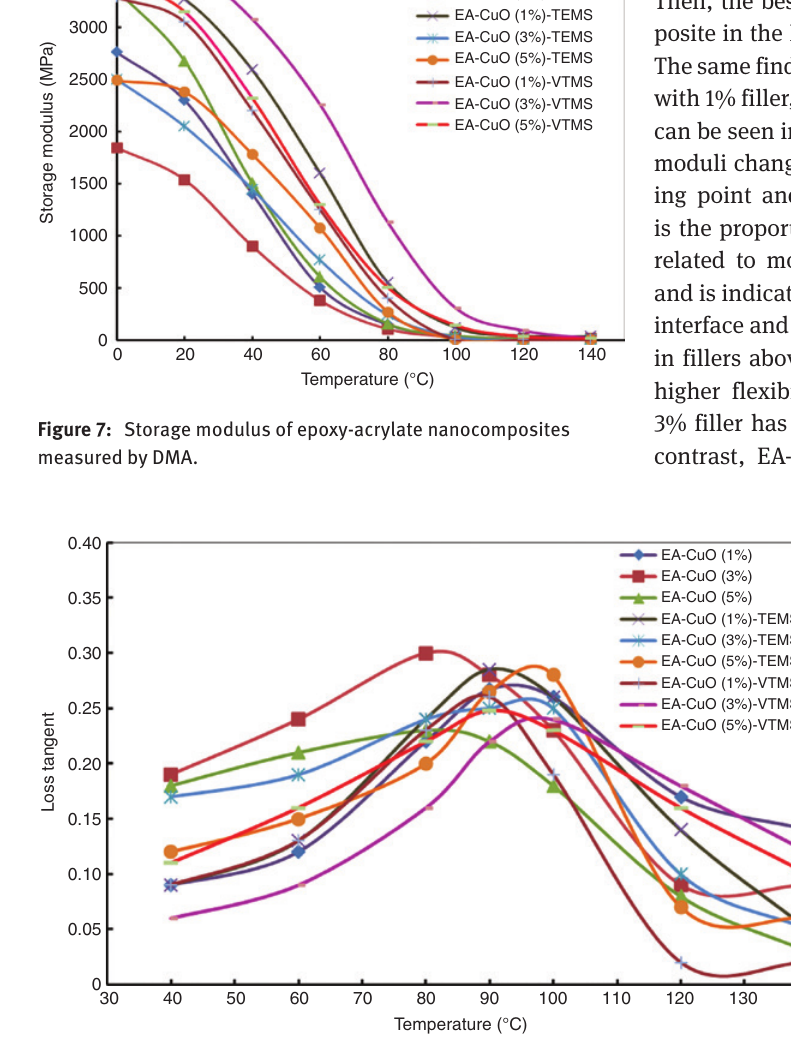
Figure 8: Loss tangent of epoxy-acrylate nanocomposites measured by DMA.